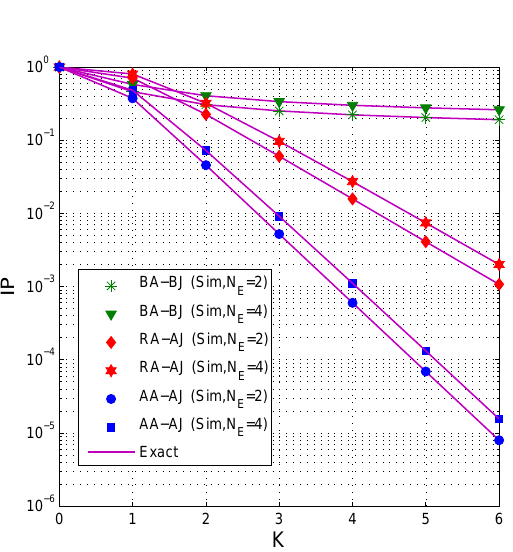
, Figure 9. IP as a function of OP when C th = 0 . 5 = 0 . N E = 2 , α = 0 . 1 , M = 3 and µ 2 E